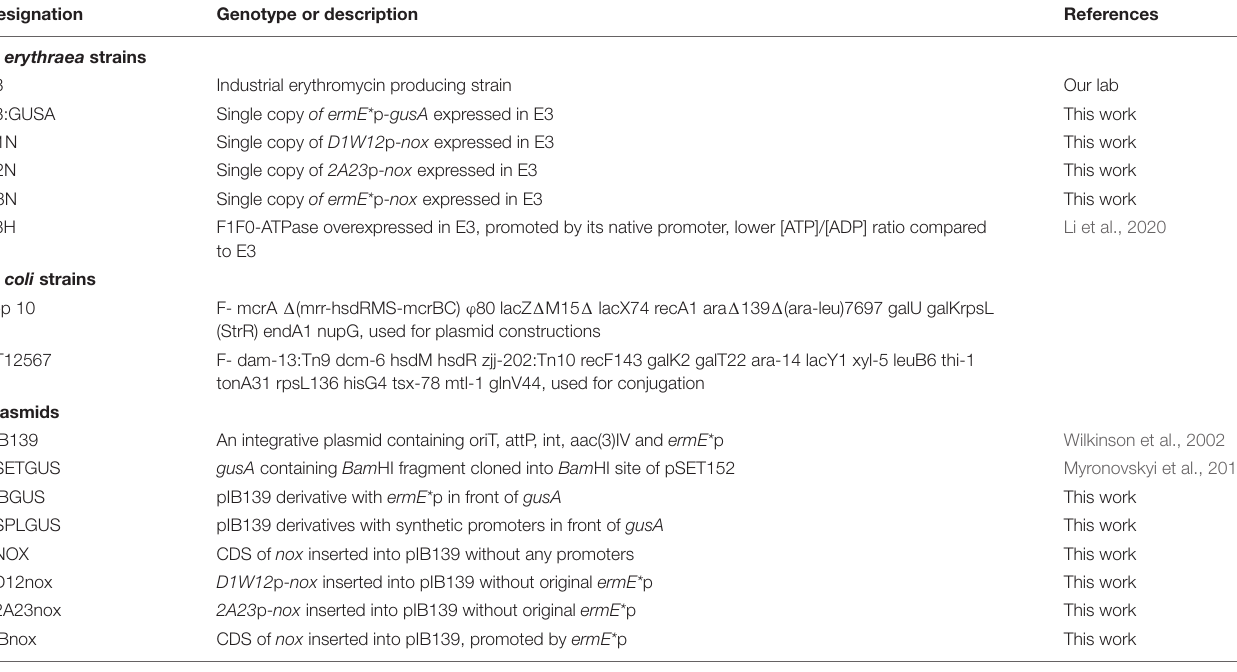
TABLE 1 | Strains and plasmids used in this study.